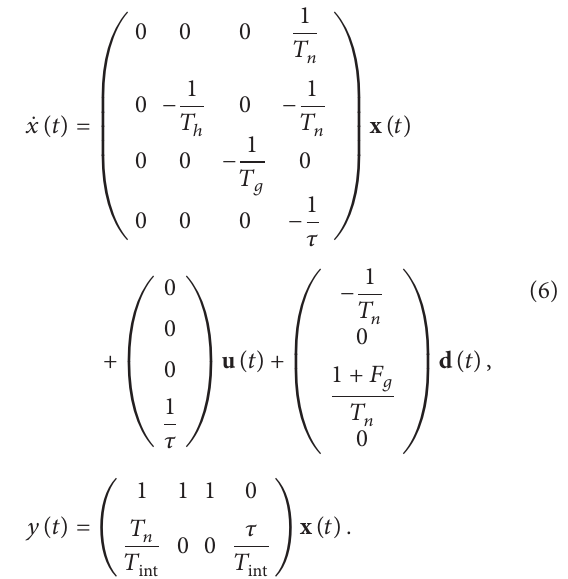
Figure 1: Schematic of the UTSG